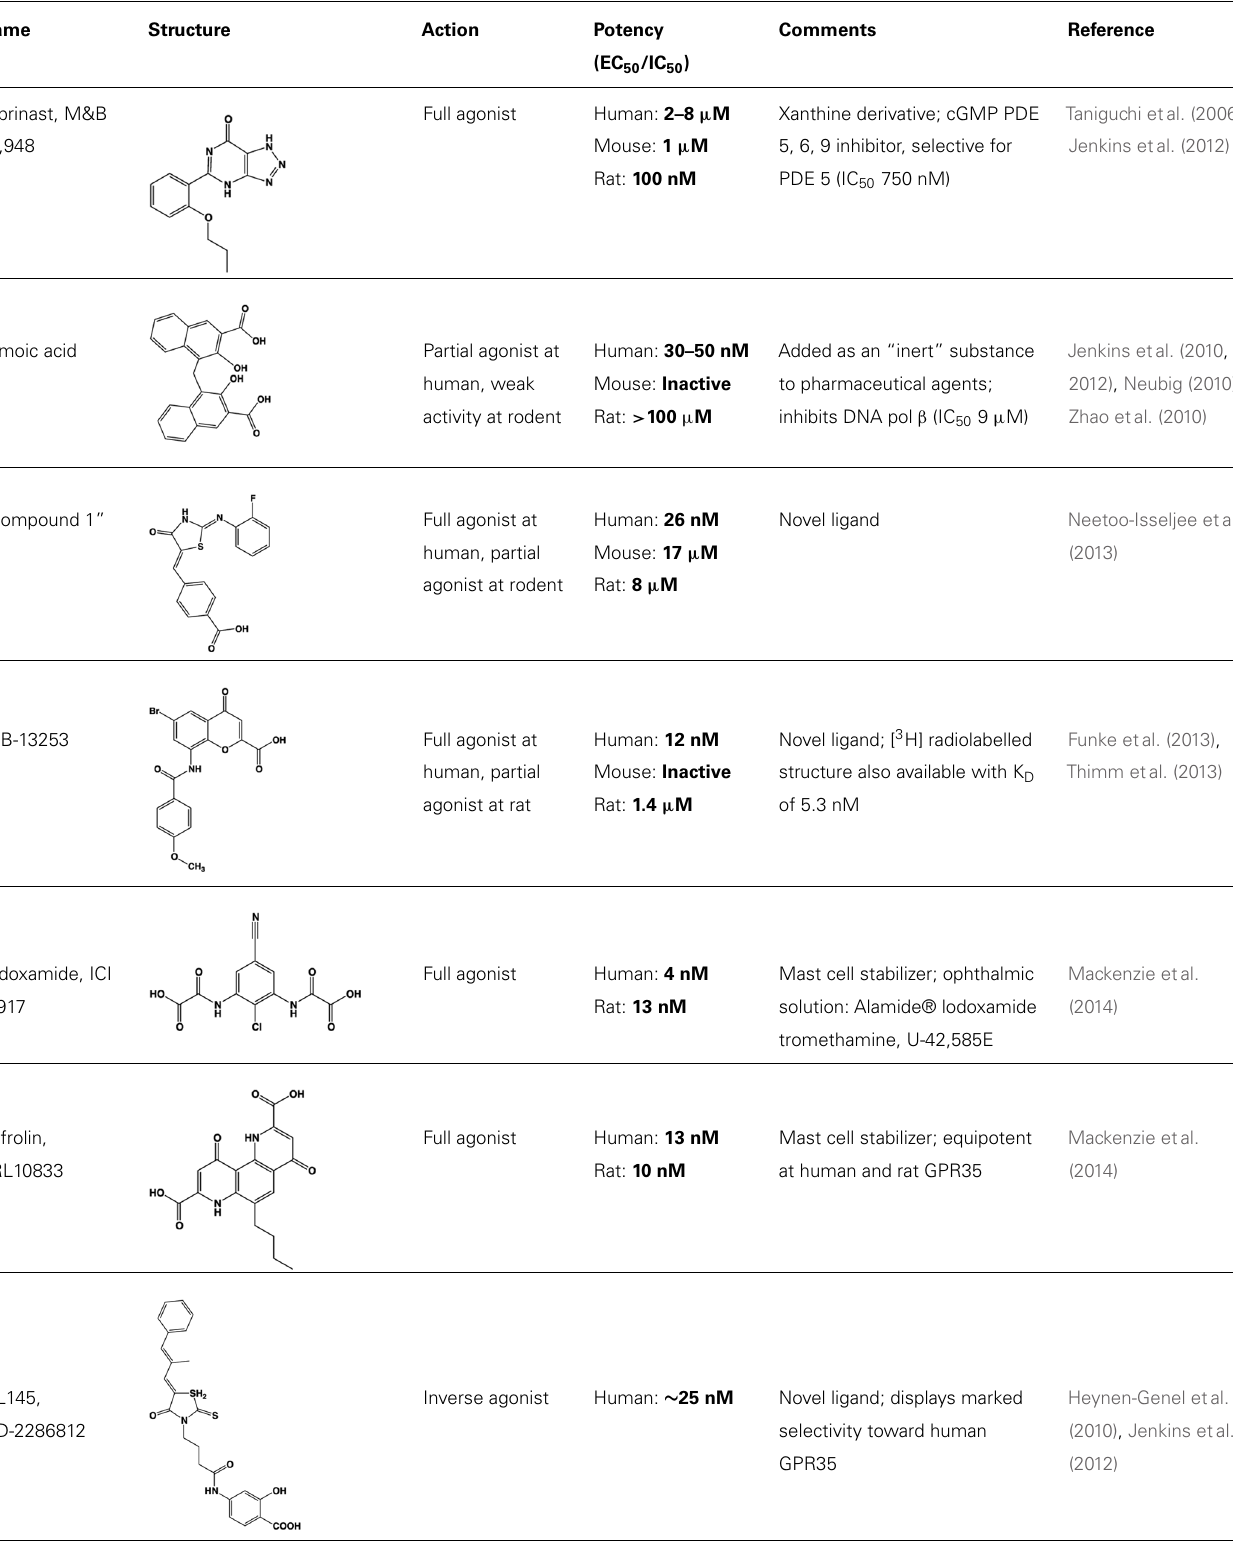
Table 2 | Potent synthetic ligands with activity at